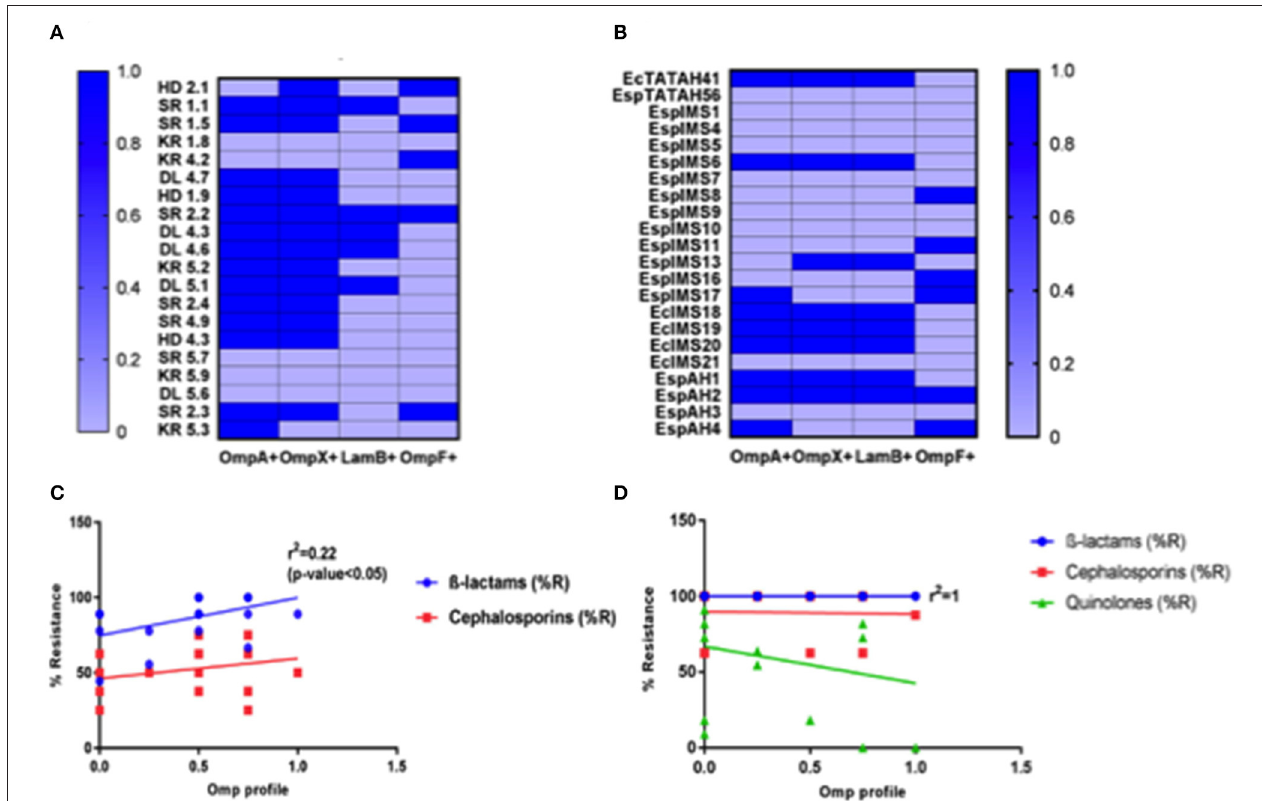
FIGURE 2 | Determination of OMP profile and its association with antibiotic resistance. Distribution of OmpA , OmpX , LamB, and OmpF in environmental (A) and clinical (B) Enterobacter isolates is presented, as deduced from multiplex PCR and slot blot hybridization experiments. OMP profile of individual isolates was then compared with their respective % resistance toward β -lactams, cephalosporins antibiotics to assess the association of OMPs with observed drug resistance, presented here as linear regression curve for environmental (C) and clinical (D) Enterobacter isolates, done by GraphPad Prism software.